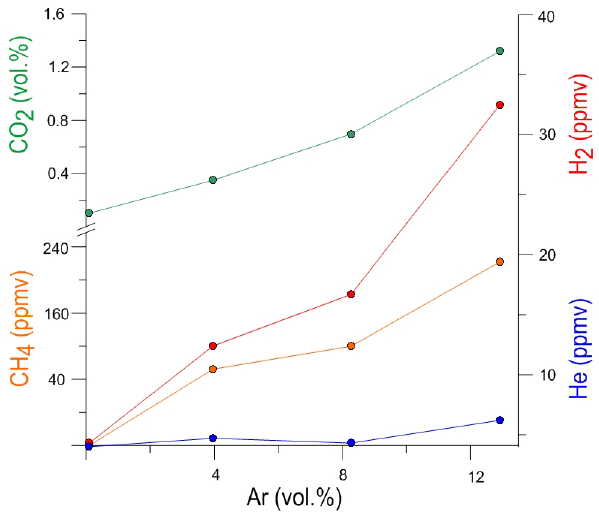
Figure 3. Average Ar-carrier gas concentration versus stripped ge- ogenic gases in the boreholes D1, D2, D3 and D5.